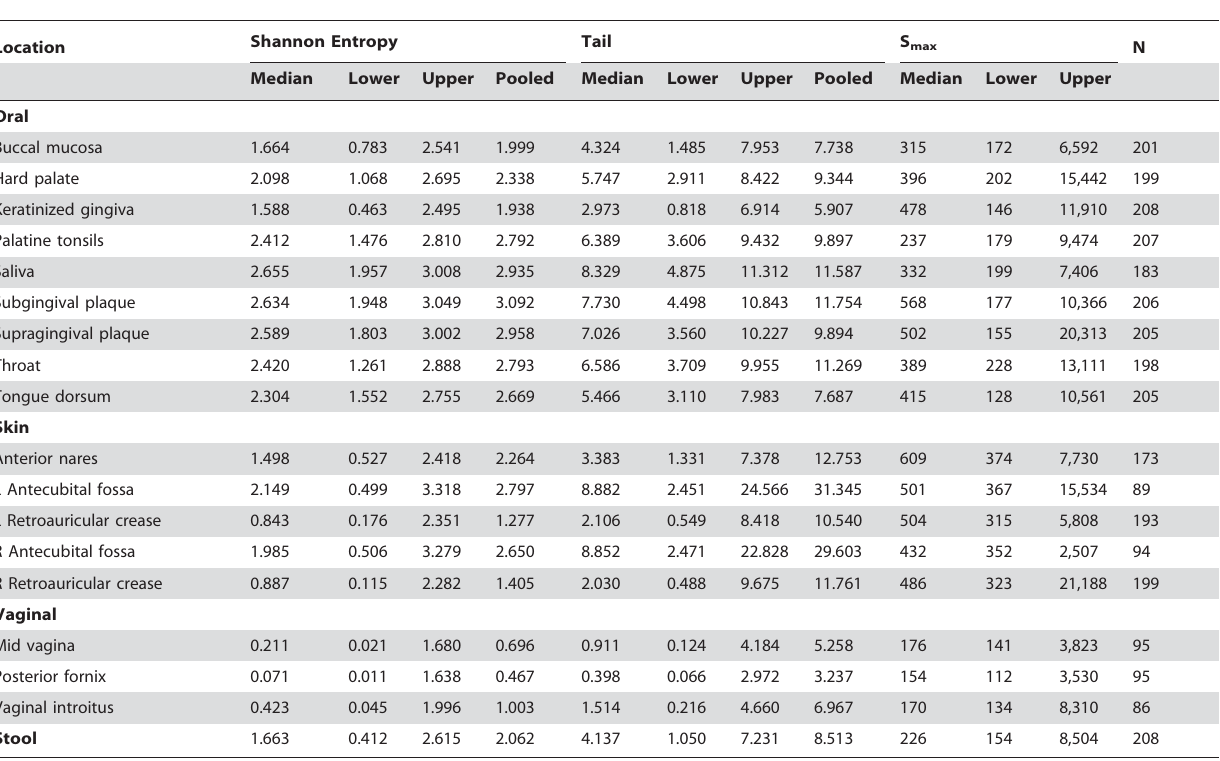
Table 1. Diversity indices computed on all genera-based taxonomic units.